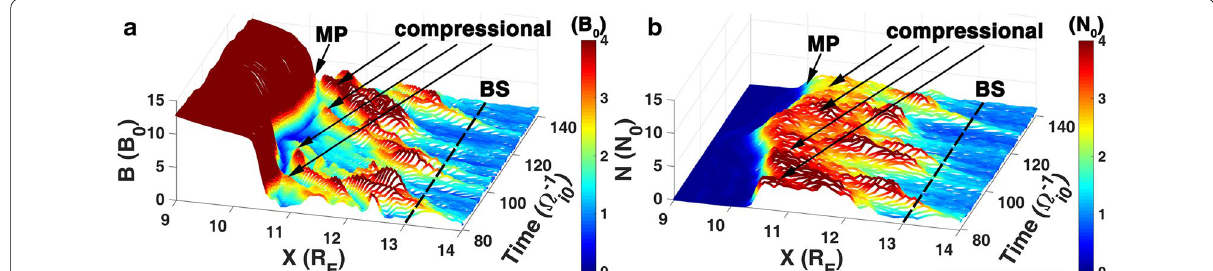
80 140 (cid:31) − 1 i 0 . The = −